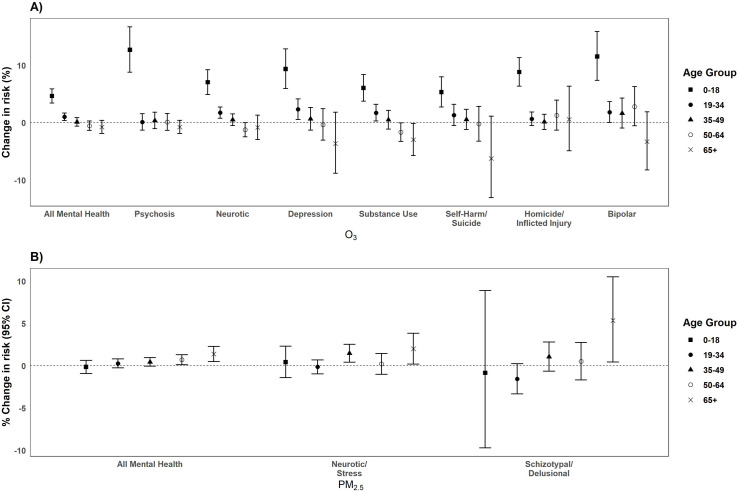
Percentage change (95% CI) in the risk of ED visits for O3 (per 10 ppb increase) (A) and PM2.5 (per 10μg/m3 increase) by age group from 2005–2013 in California.1 Bars: 95% Confidence Interval; CI: Confidence Interval; ED: Emergency Department; ppb: parts per billion. 1Only significant outcomes shown.